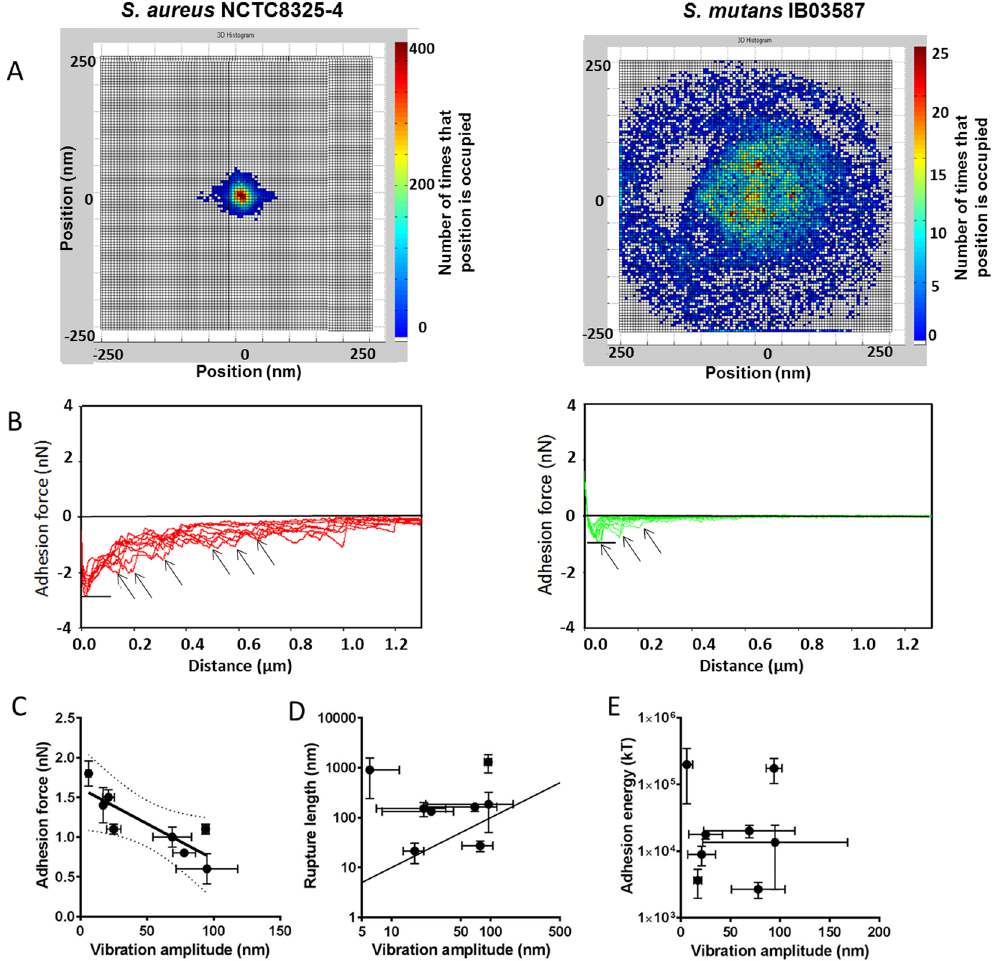
Figure 1. Bacterial adhesion forces, rupture lengths and energies for a variety of coccal strains and species as a function of their vibration amplitudes when adhering to a glass substratum. ( A ) Two examples of nanoscopic position-maps for S. aureus NCTC8325-4 and S. mutans IB03987 adhering to a glass surface, from which vibration amplitudes can be calculated. Pseudo-colors indicate the number of times a position was found occupied by the bacterium. ( B ) Two examples of force-distance curves as in single-bacterium contact probe AFM for S. aureus NCTC8325-4 and S. mutans IB03987 on a glass surface. The strongest force recorded during retraction, indicated by the horizontal line, is taken as the adhesion force 20 , while arrows indicate local minima indicative of detachment of different individual tethers (“adhesion peaks” 20 ). Different lines of the same color indicate multiple measurements with one bacterial probe, taken in a random time sequence over the glass surface with respect to the lines. ( C ) Bacterial adhesion forces as a function of vibration amplitudes for different bacterial strains and species (see also Table 1). Error bars denote the standard errors of the means (see also Table 1). The drawn line indicates the best fit to a linear function with a correlation coefficient R 2 of 0.72 (p < 0.01). Dotted lines indicate the 99% confidence limits. ( D ) Same as panel C, now for the rupture length as taken from the retract part in the force-distance curves. The line indicates the line of identity, where rupture lengths and vibration amplitudes match. ( E ) Same as panel C, now for the adhesion energy, i.e. the area under the force-distance